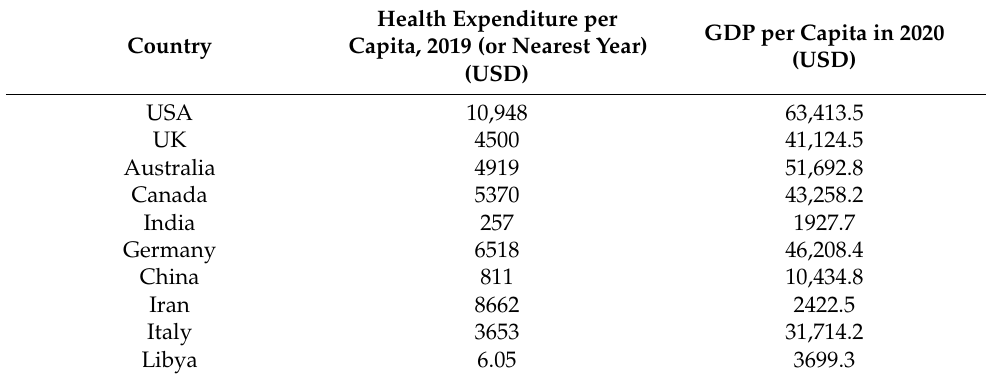
Table 8. Countries with the highest scientific production in our analysis in relation to GDP per capita and heath expenditure per